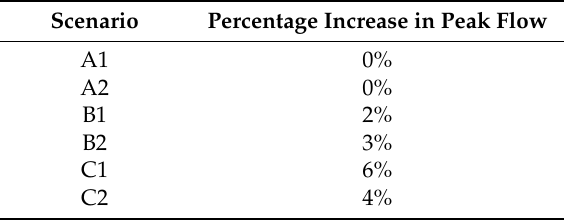
Table 7. Percentage increase in peak flow downstream of pond system for a 1-in-20 year event for the six SWH scenarios compared with the existing